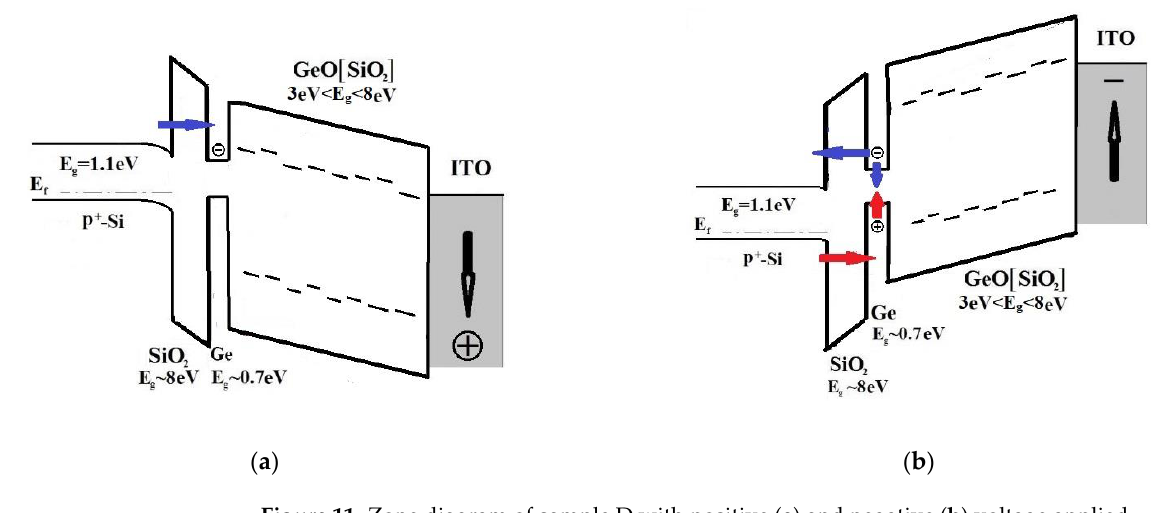
With repeated cycling, a decrease in the memory window is observed during the first 500 rewriting cycles. Current in the ON-state tends to decrease. The OFF-state cur- rent remains quite stable. However, compared to sample A, the endurance for sample D Figure 11. Zone diagram of sample D with positive ( a ) and negative ( b ) voltage applied. is lower.